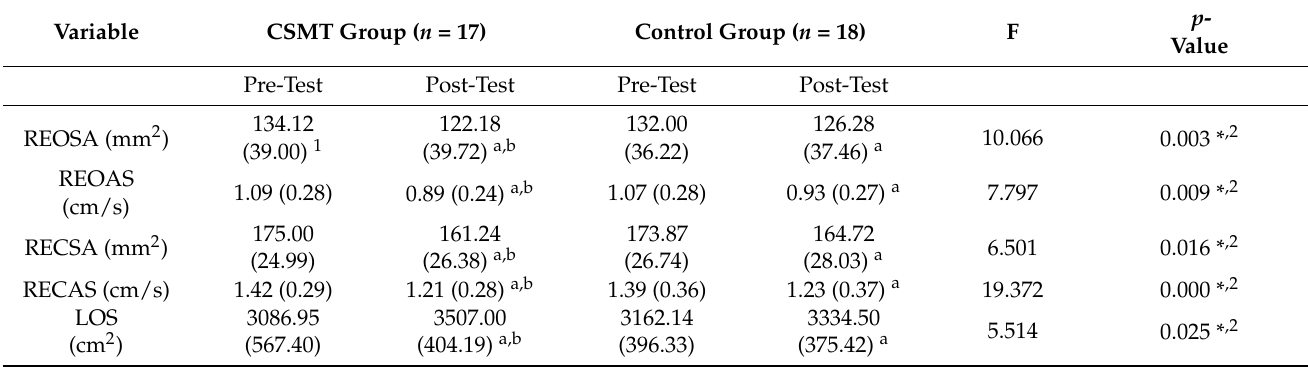
Table 4. Comparison of balance ability between CSMT and Control group ( N =